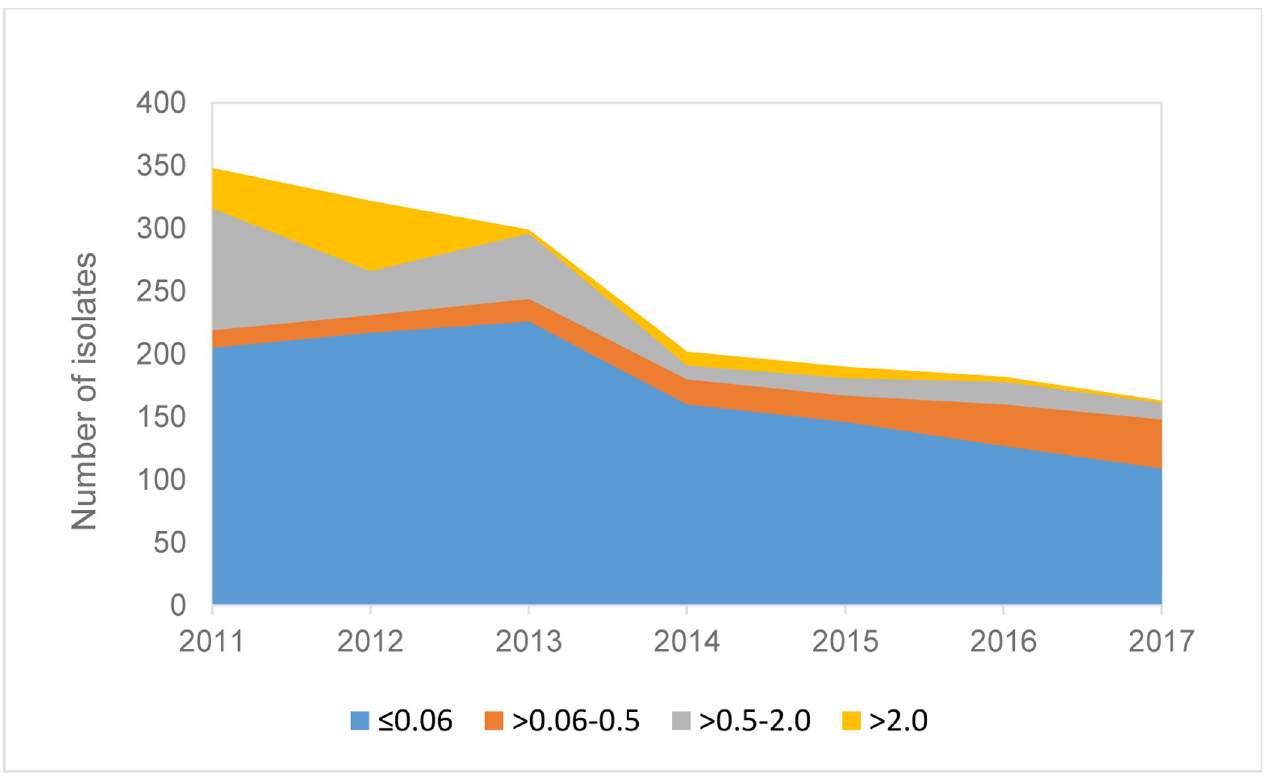
Fig 3. The MIC values (mg/L) of all 1,706 pneumococcal isolates according to years. Oxacillin sensitive and isolates with confirmed penicillin MIC of � 0.06 mg/L were defined as sensitive; intermediate with relatively low MIC values, > 0.06–0.5 mg/L; intermediate with relatively high MIC values, > 0.5–2.0 mg/L; and resistant isolates with penicillin MICs of > 2.0